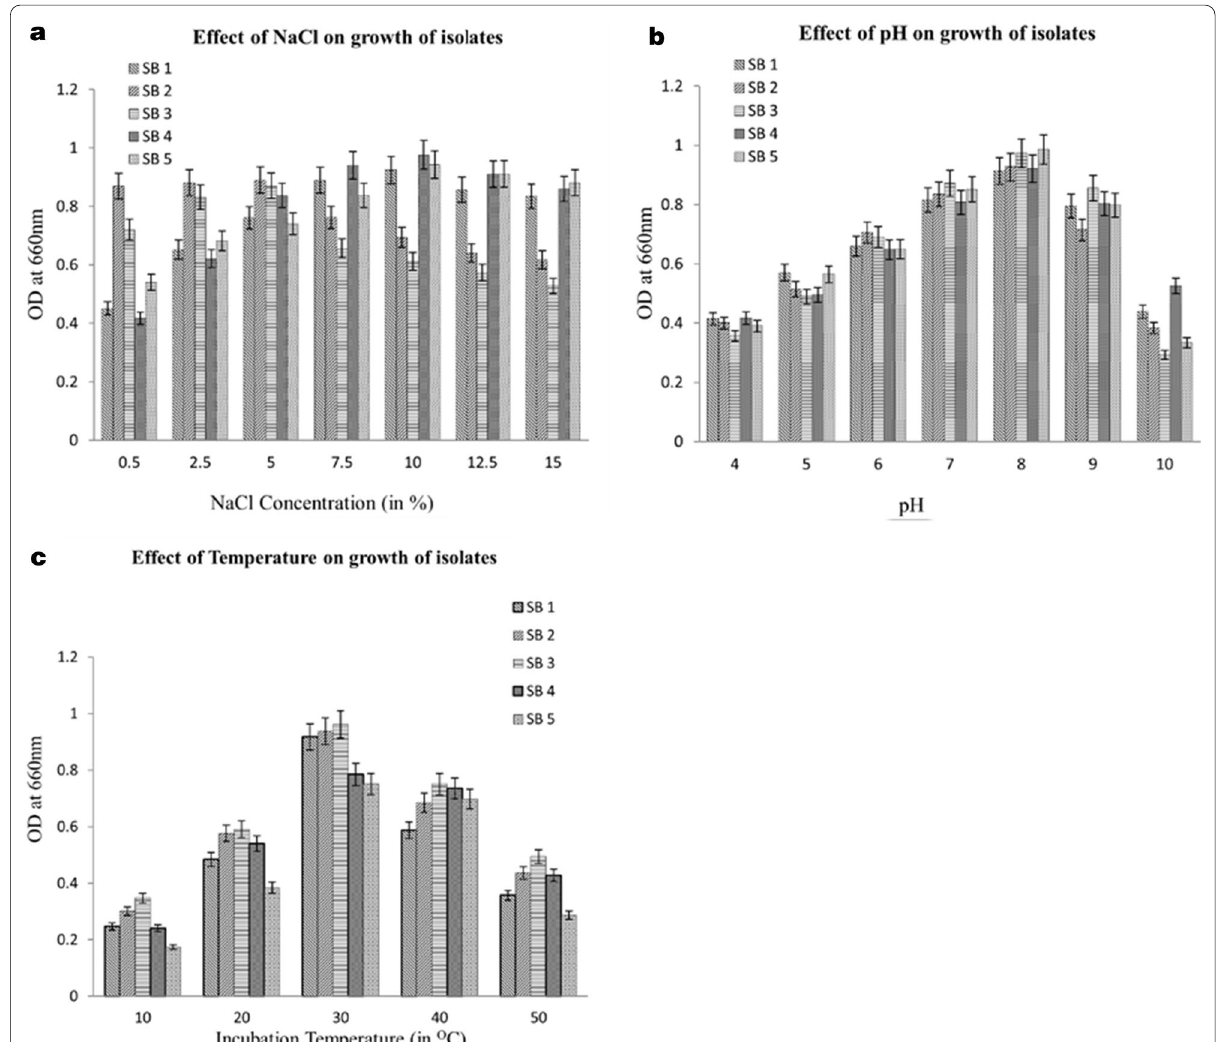
Fig. 1 Growth comparison of different isolated bacteria under different abiotic conditions a NaCl concentration 0.5–15%, b pH 4–10 and c